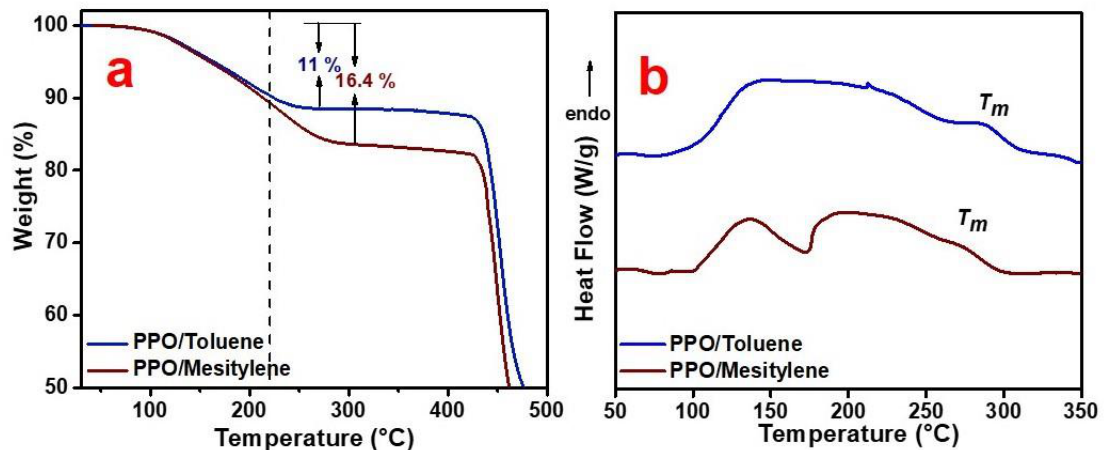
Figure 2. TGA ( a ) and differential scanning calorimetry (DSC) ( b ) scans at heating rate of 10 °C/min of PPO co-crystalline (CC) films with toluene (blue lines) and mesitylene (brown lines). The TGA scan of Figure 2a (upper curve) indicates a toluene content close to 11 wt.%, with guest